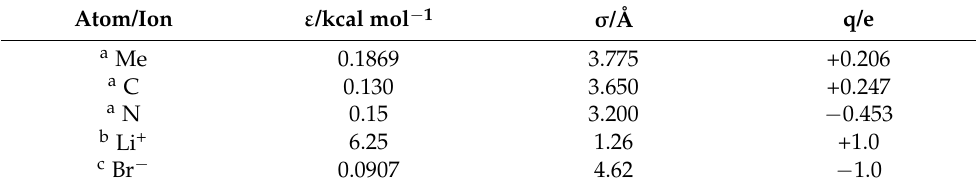
Table 1. Lennard–Jones Interaction potential parameters.